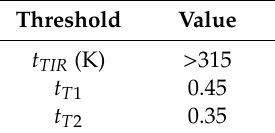
Table 1. Thermal-infrared camera threshold values for the IJR height detection algorithms.